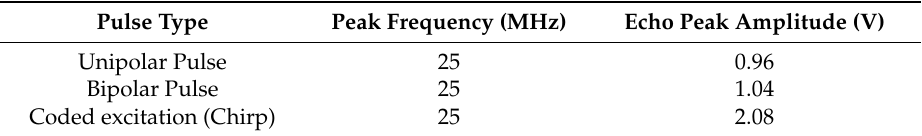
Table 6. The relationship between the pulse type and echo peak